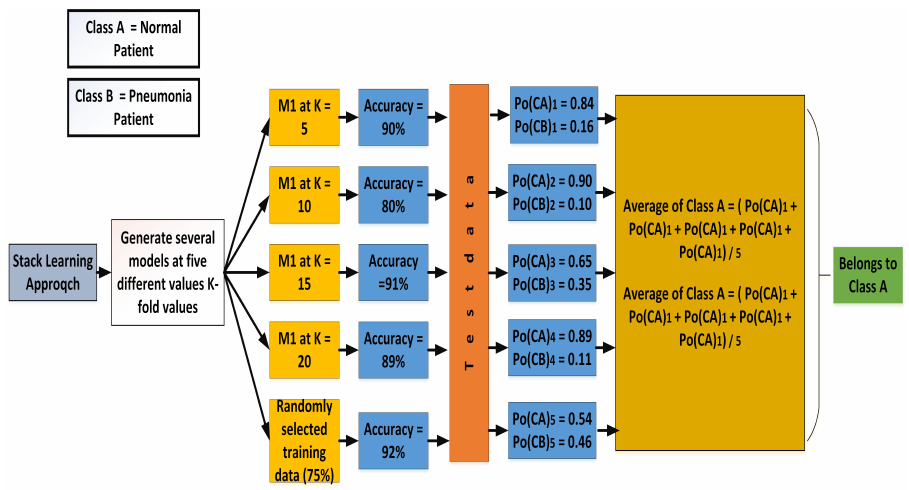
Figure 14. Classification after applying hard voting.